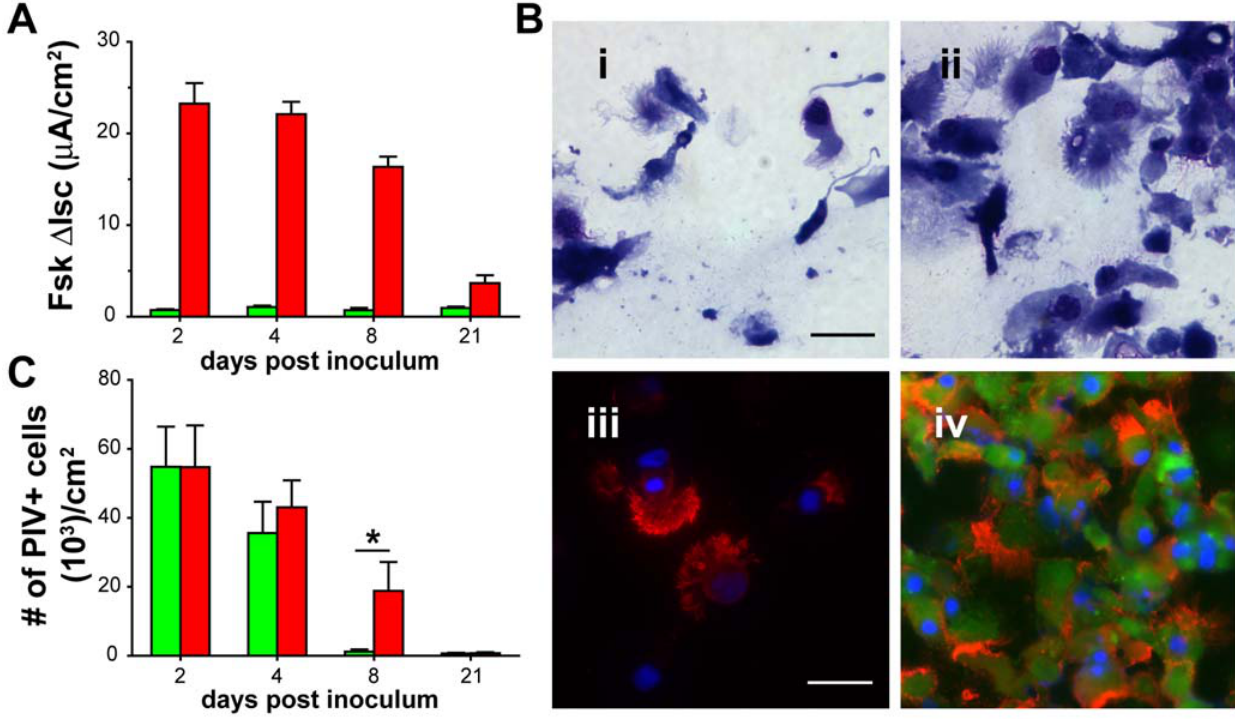
Figure 6. Duration of CFTR functional correction is limited by shedding of PIV-infected ciliated cells. (A) Duration of CFTR functional activity in PIV corrected CF HAE. CF HAE were inoculated with PIVCFTR (red bars) or PIVGFP (green bars) at day 0, and ion transport studies were performed at days specified ( n =8 cultures derived from 3 different patients). Significant CFTR function could be measured for up to 8 d but waned by 21 d pi in CF HAE inoculated with PIVCFTR. No significant CFTR function was detected in CF HAE inoculated with PIVGFP. (B) Histological Cytospin assessment of cells shed into apical surface secretions at day 6 pi showing few shed ciliated cells in mock-inoculated CF HAE (i and iii), whereas significant numbers of cells were shed after PIVGFP (ii and iv). Cytospinned apical washes were counterstained with Giemsa (i and ii) or probed with Abs to GFP (green) and acetylated alpha-tubulin (red) to show ciliated cells. Bar represents 20 m m. Images are representative of Cytospins from two individual experiments. (C) Loss of PIV F-positive cells over time after inoculation with PIVCFTR (red bars) or PIVGFP (green bars), showing that PIVCFTR and PIVGFP infected equal numbers of ciliated cells at day 2, but that ciliated cell shedding was delayed for PIVCFTR versus PIVGFP by day 8. Data derived from same dataset in (A). An asterisk (*) denotes p , 0.05. Error bars indicate